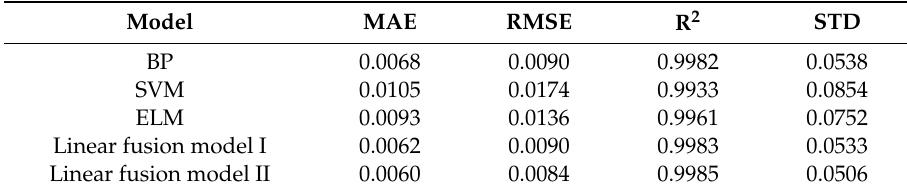
Table 6. Performance indicators of five kinds of models.